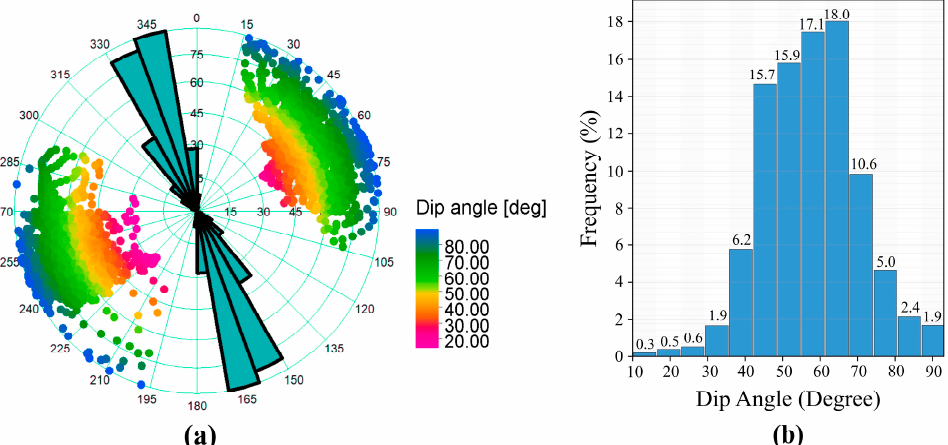
Figure 9. ( a ) Steroenet showing the distribution of faults’ dips and orientations identified, along with the entire seismic survey in the Kadanwari field, MIB, Pakistan; ( b ) a histogram showing the dip angles of the interpreted faults along with their frequency.